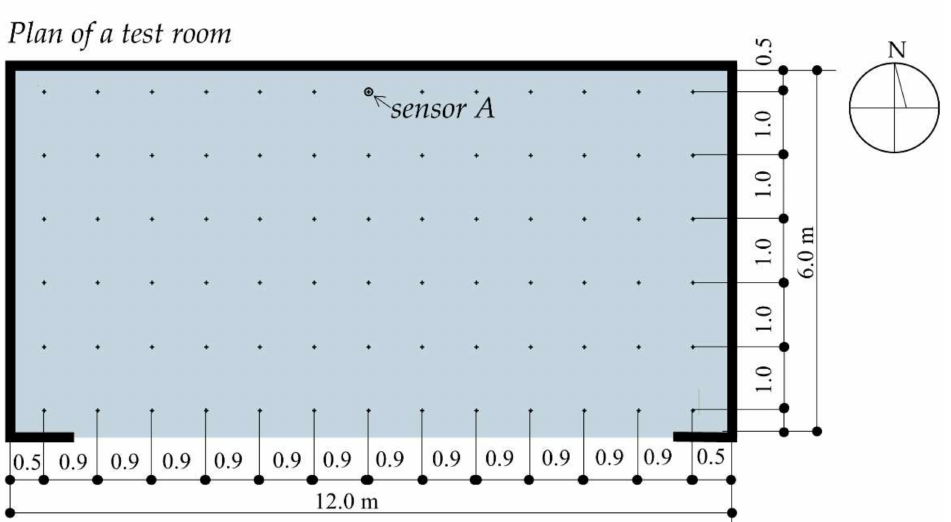
Figure 3. Test room plan: the dimension of the working plane and the location of measuring sensors. The values of illuminance in sensor A are used in the adaptive scenario Variant